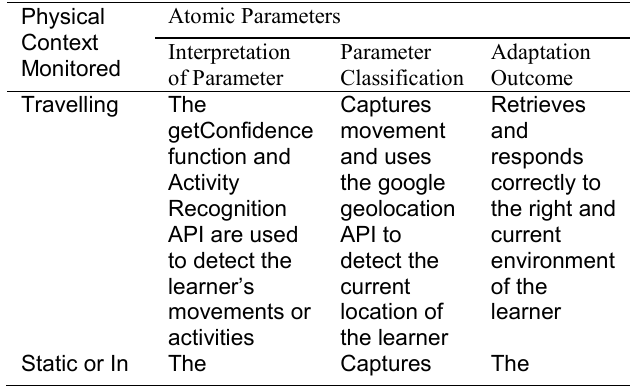
Table 2. Atomic parameters tested – Physical